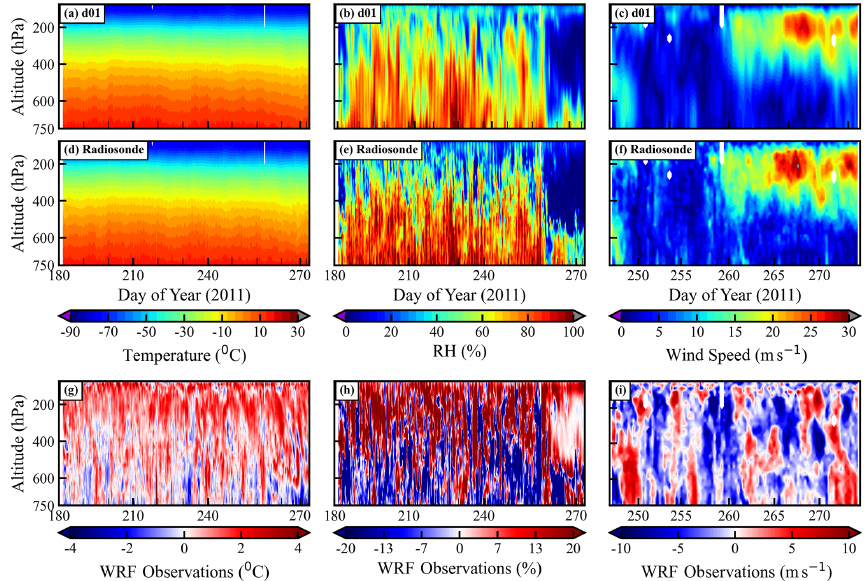
Figure 3. The comparison of simulated vertical profiles of (a) temperature ( ◦ C), (b) relative humidity (RH; %), and (c) wind speed (ms − 1 ) in d01 with the radiosonde observations (d, e, f) . The x axis in (a) , (b) , (d) , (e) , (g) , and (h) shows the day of the year in 2011 starting from 1 July (182nd day) to 30 September (273rd day). The vertical profiles of wind speed (c, f) are plotted only for September 2011. The third row (g, h, i) shows the difference in temperature, relative humidity, and wind speed between the WRF d01 simulation and radiosonde